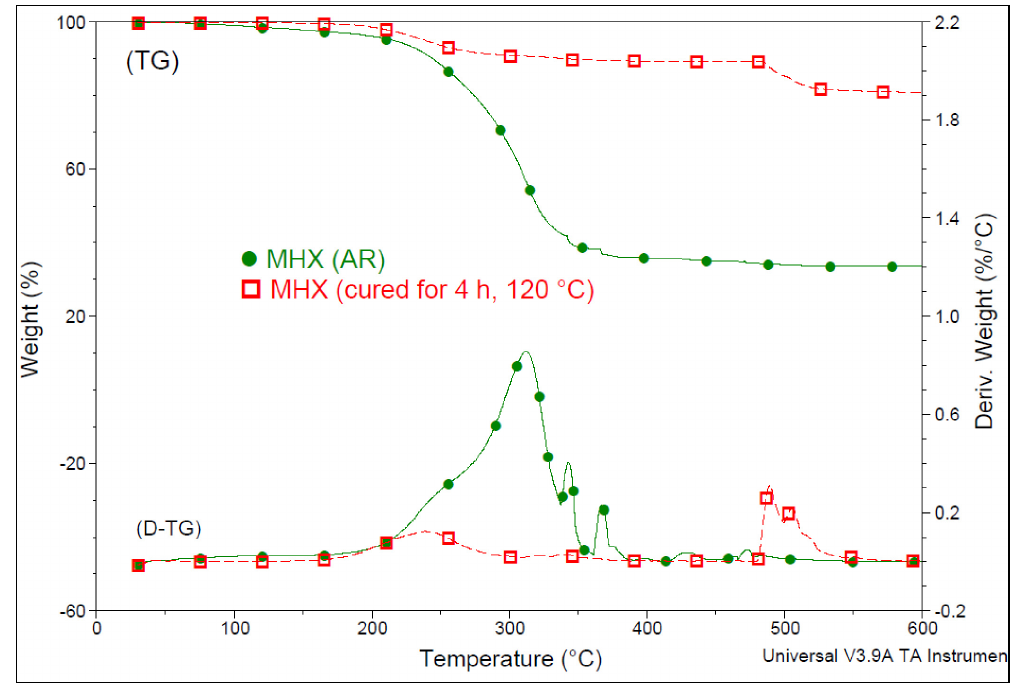
Figure 1. Thermogravimetric (TG) and derivative thermogravimetric (D-TG) curves of MHX with a different thermal history (under N 2 , 20 °C/min).